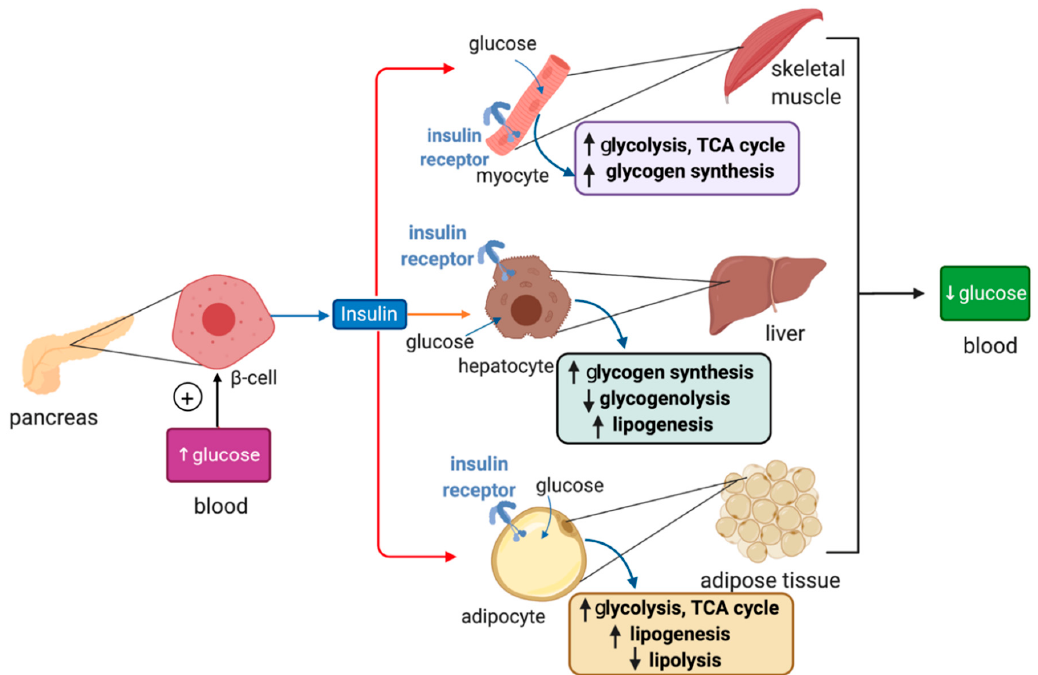
Figure 2. Hormonal regulation of glucose metabolism by insulin. Insulin is synthesized in pancreatic β cells in response to hyperglycemia. It binds to insulin receptors in target cells (red arrows) such as skeletal muscle cells, hepatocytes and adipocytes and induces signaling pathways that promote glucose uptake, catabolism or storage. This reduces plasma glucose levels.